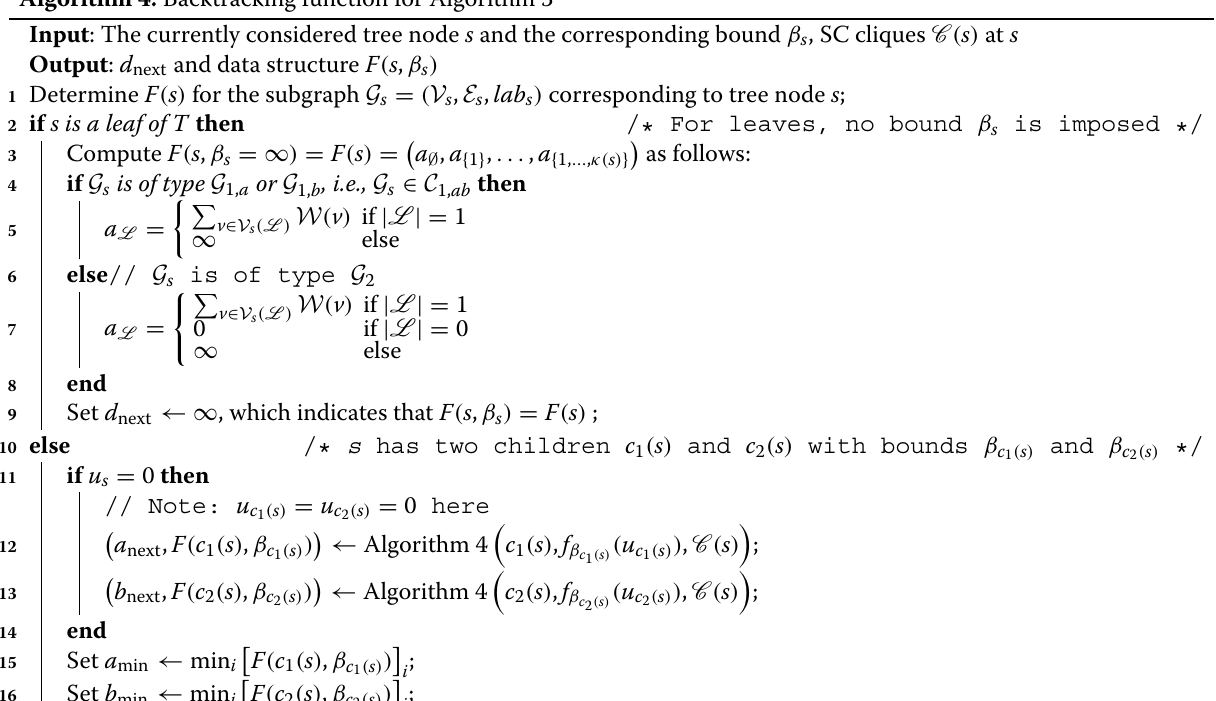
Algorithm 4: Backtracking function for Algorithm